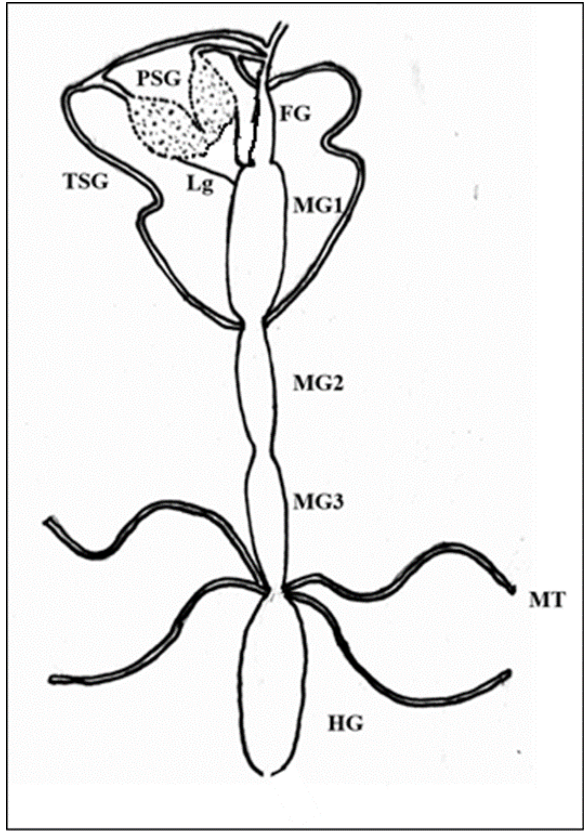
Figure 1. Schematic diagram of alimentary canal and salivary glands of Thrips palmi. FG—foregut; MG1—midgut 1; MG2—midgut 2; MG3—midgut 3; HG—hindgut; PSG—principal salivary gland; MG1—midgut 1; MG2—midgut 2; MG3—midgut 3; HG—hindgut; PSG—principal salivary